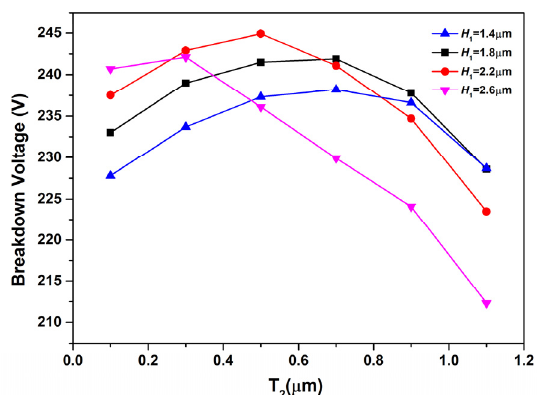
Figure 9. Dependence of the BV on the width of floating electrodes ( T 2 ) at different length ( H 1 ) for the DFSGRSO UMOSFET.